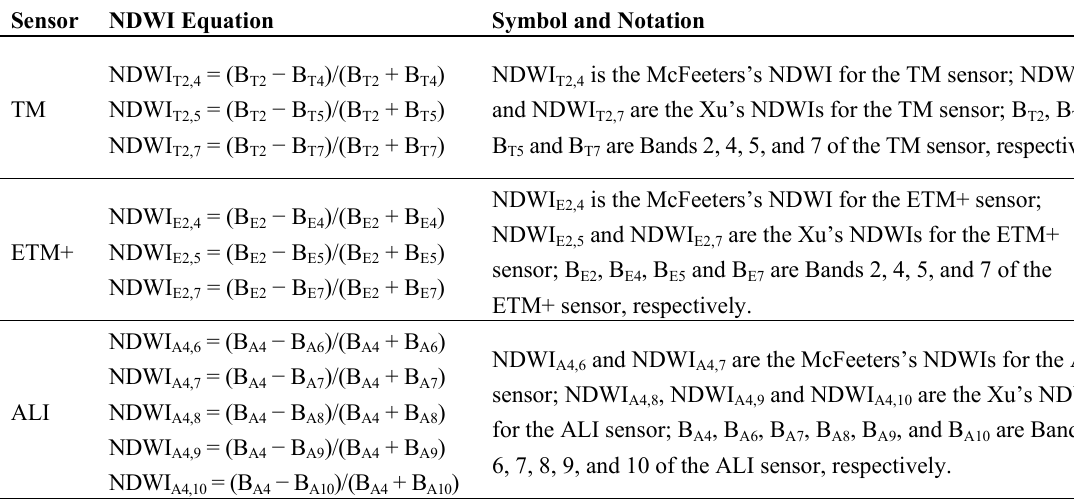
Table 2. Normalized difference water index equations and associated sensors (T: TM, E: ETM+, A: